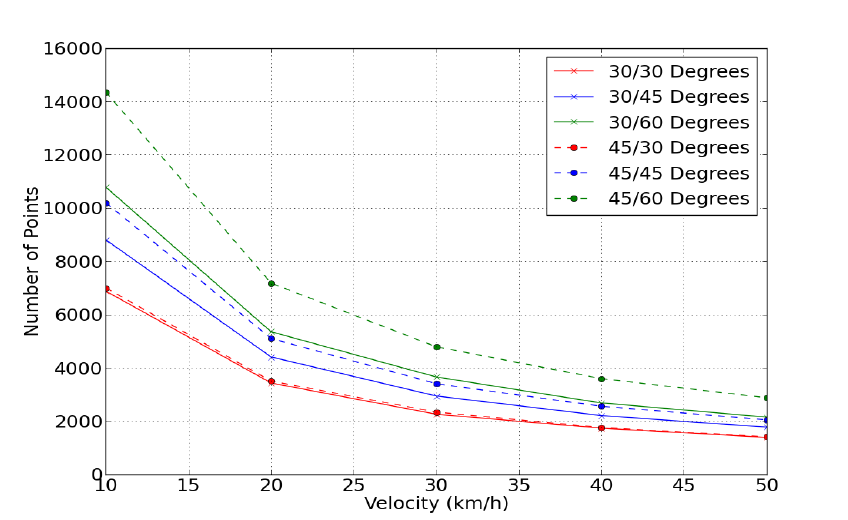
Figure 8. Optimising scanner orientation: Identifying the recommended dual axis scanner rotation for increasing the number of pulses striking a parallel vertical target at different vehicle velocities. Target range was 5 m and target dimensions were 2 m × 1